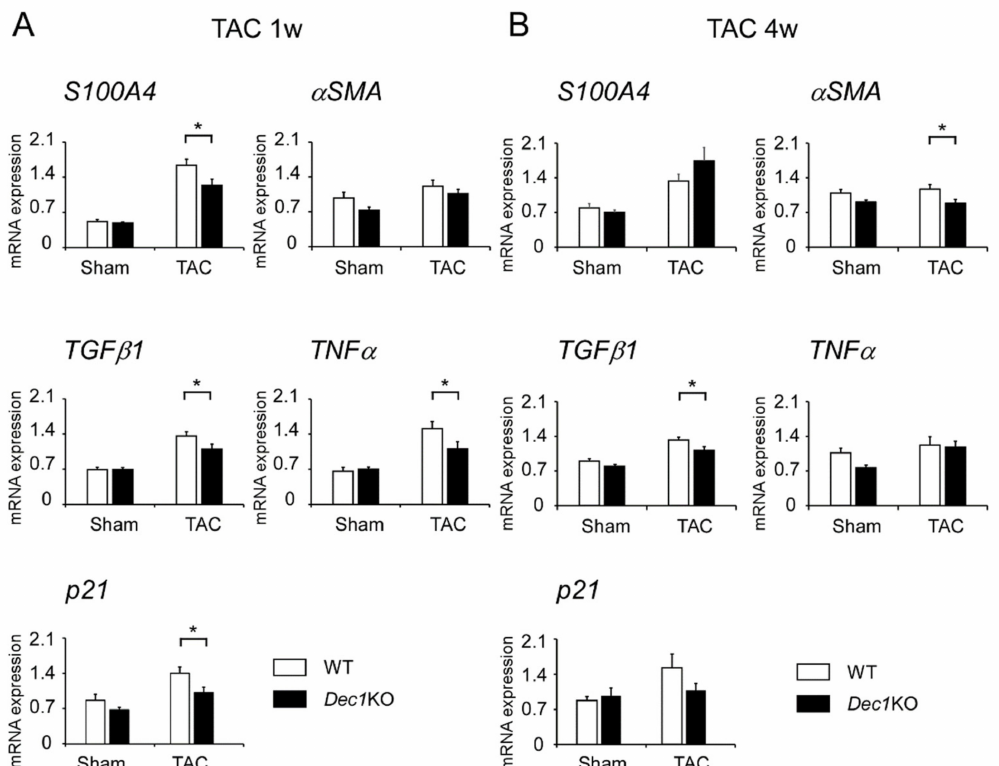
Figure 6. Dec1 deficiency a ff ects the mRNA expressions of S100A4 , α SMA , TGF β 1, TNF α , and p21 after TAC. ( A ) The relative mRNA expression of S100A4 , α SMA , TGF β 1 , TNF α , and p21 in WT and Dec1 KO hearts at one week after TAC ( n = 11–13 mice per group) and sham treatment ( n = 5–6 per group). The mean comparison between WT and Dec1 KO mice after TAC and sham treatment was analyzed by a two-tailed Student’s t -test with 95% confident interval (CI). For TAC groups, the p -values were as follows: S100A4 , 0.03 (95% CI: 0.0448, 0.7473); TGF β 1 , 0.04 (95% CI: 0.0134, 0.5095); TNF α , 0.04 (95% CI: 0.0092, 0.7970); p21 , 0.04 (95% CI: 0.0202, 0.7586). For sham groups, none were significant. The white box indicates WT, and the black box indicates Dec1 KO. ( B ) Four weeks after operations ( n = 8–11 mice per group). For TAC groups, the p -values were as follows: α SMA , 0.02 (95% CI: 0.0413, 0.5321); TGF β 1 , 0.03 (95% CI: 0.0197, 0.3988). For sham groups, the p -value was as follows: TNF α , 0.01 (95% CI: 0.0656, 0.5337). Data are means ± SEM. * p < 0.05; NS: not